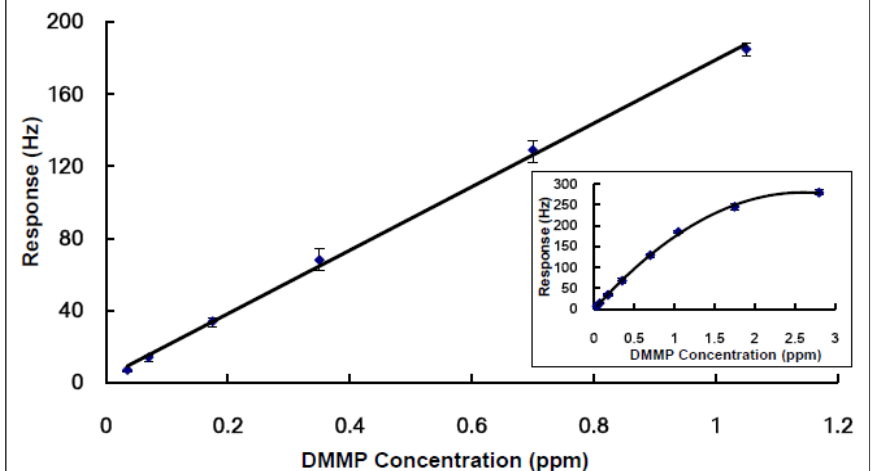
Figure 5. Linear plot of the reciprocal of a ZnO-modified nanowire MnO sensor’s response against the concentrations of DMMP vapor purged in high-purity nitrogen at room